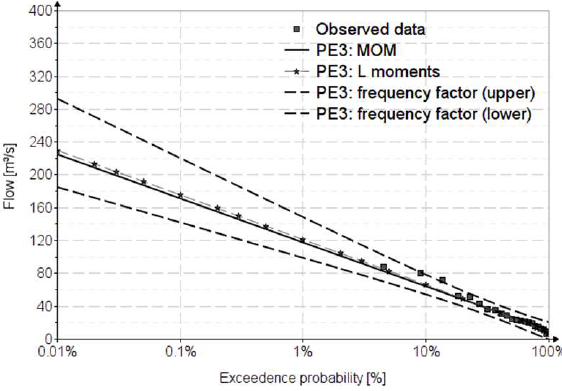
Figure 8. Pearson III distribution.